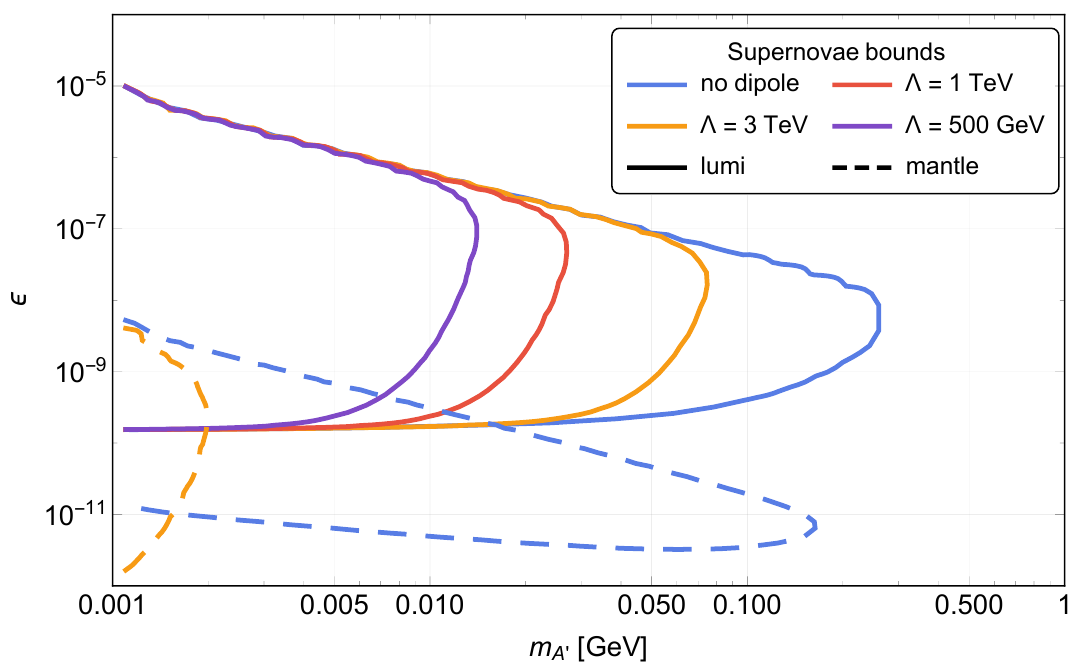
Figure 4 . Excluded region obtained for SN1987A. The solid curves are excluded by requiring that the dark photon luminosity is smaller than the neutrino one. The dashed curves are excluded by the dark photon decaying in the mantle argument. The blue curves denote the limits obtained in the absence of the dipole operator, while the other curves show the limits for different values of Λ by fixing d = 1 e